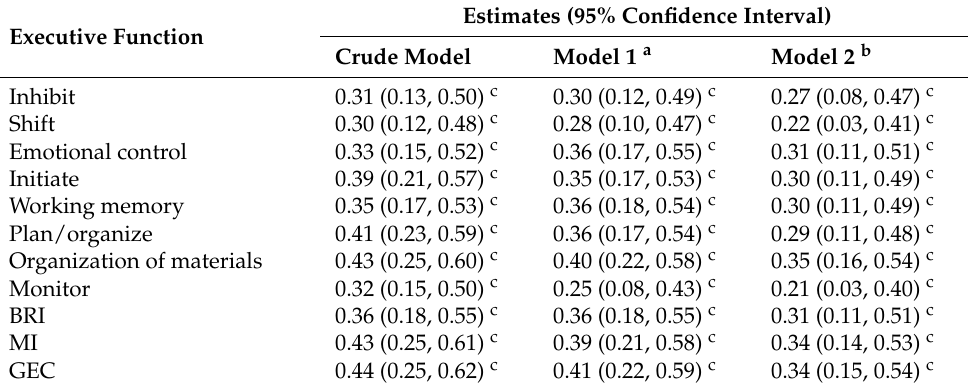
Table A2. Association between the total servings of SSB consumption a week and executive function ( n = 6387).